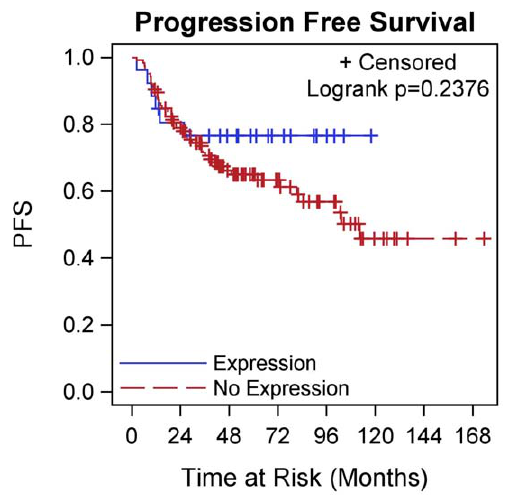
Figure 3. PFS by NY-ESO-1 expression in TNBC. Kaplan-Meier curve showing PFS differences in patients with TNBC stratified by NY-